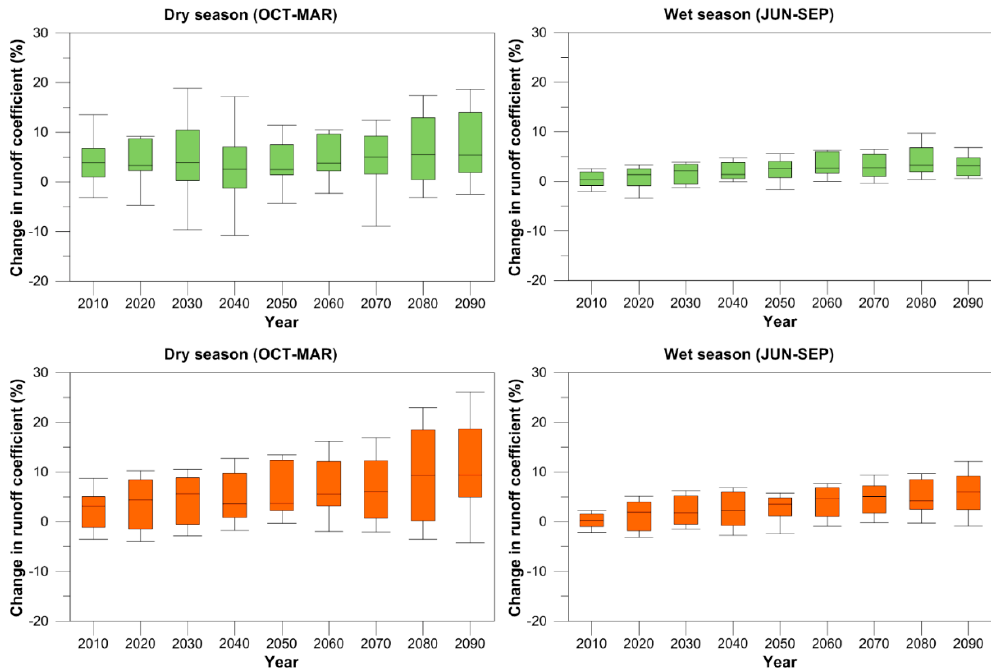
Figure 6. The 30-year moving average runoff coefficient referred to the baseline (1976–2005) during dry ( left ) and wet ( right ) seasons in RCP 4.5 (green) and RCP 8.5 (orange). The boxes show the interquartile range, the lines within the boxes show the median, and the upper and lower portions of the whiskers show the maximum and minimum estimations. The average values of the change in the runoff coefficients in 109 subbasins for each year of the period 2000–2099 are used to compute the 30-year moving average; “2010” represents the 30-year moving average of the period 2000–2019, “2020” represents the 30-year moving average of the period 2010–2029, and so on.